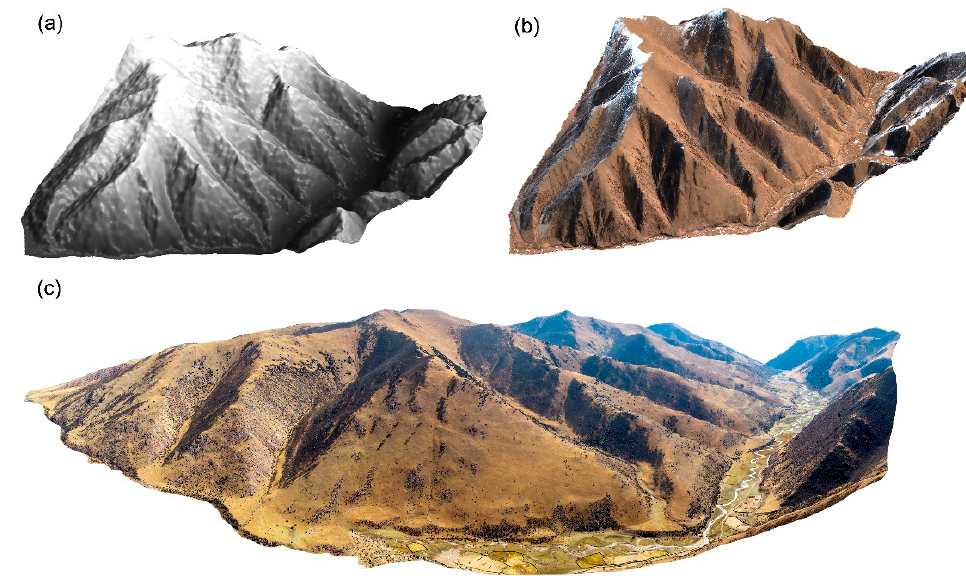
Figure 2. Examples of data used in the study, ( a ) hillshade from DEM, ( b ) true color Gaofen-2 satellite image, and ( c ) the photo in the same region.